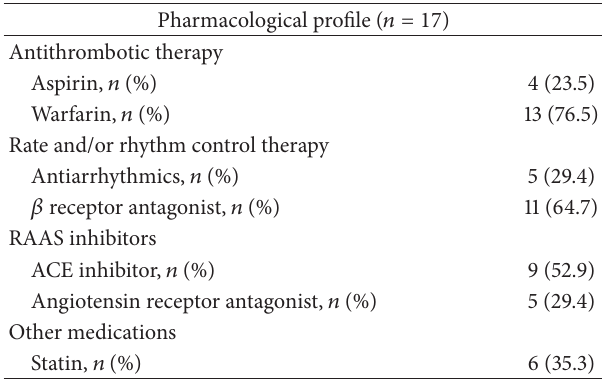
Table 2: Pharmacological therapy present in the study cohort.